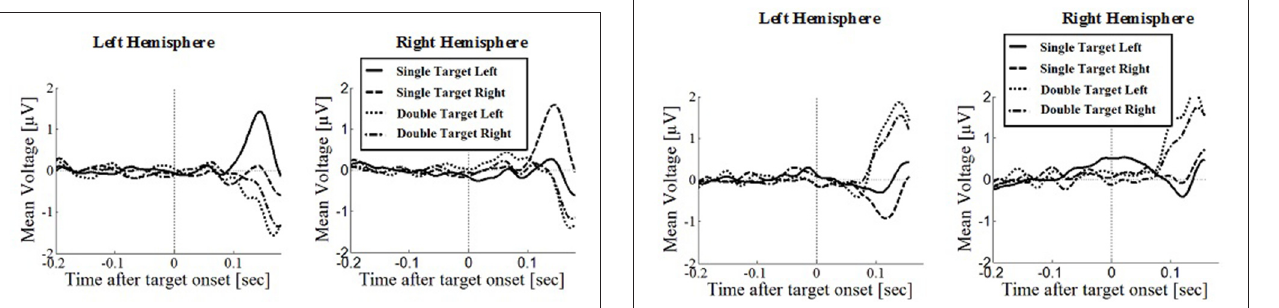
FIGURE 8 | Wave plot of the prefrontal response for manual response conditions in the left hemisphere (left) and the right hemisphere (right) of the